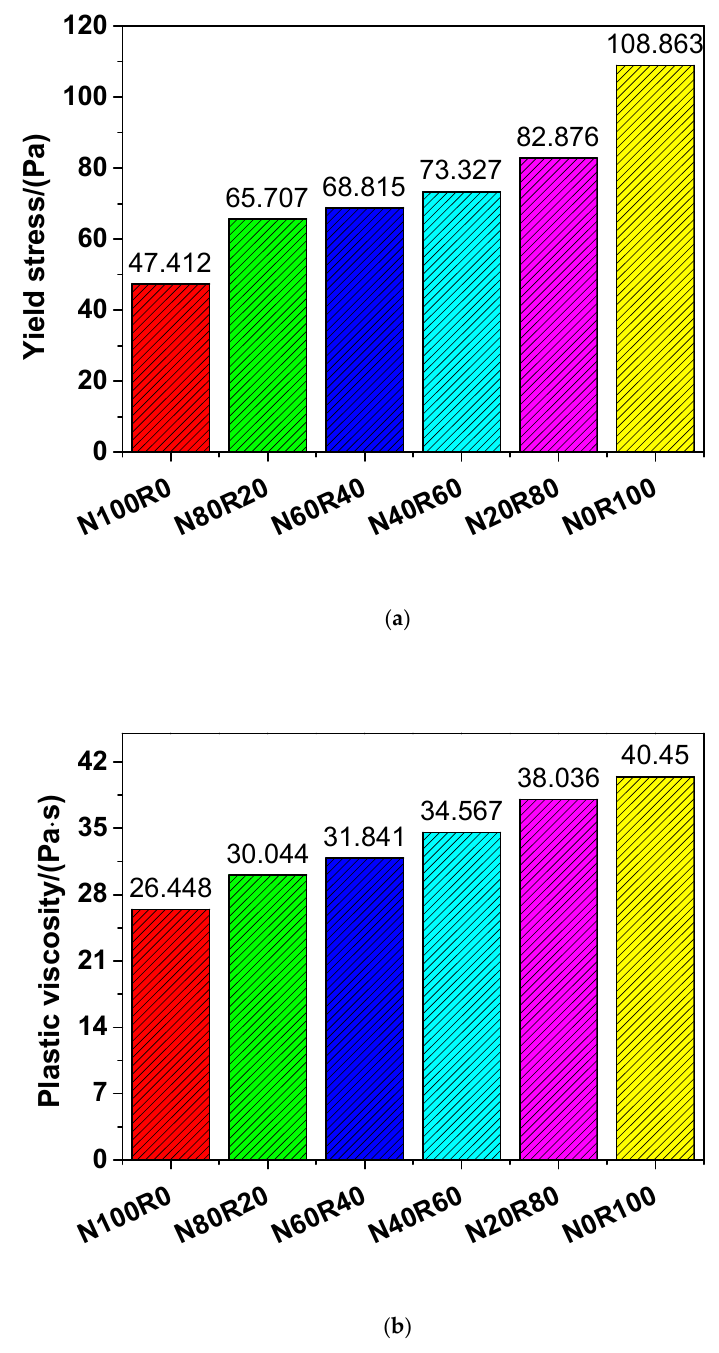
Figure 3. Rheological parameters of UHPC: ( a ) Yield stress and ( b ) Plastic viscosity.